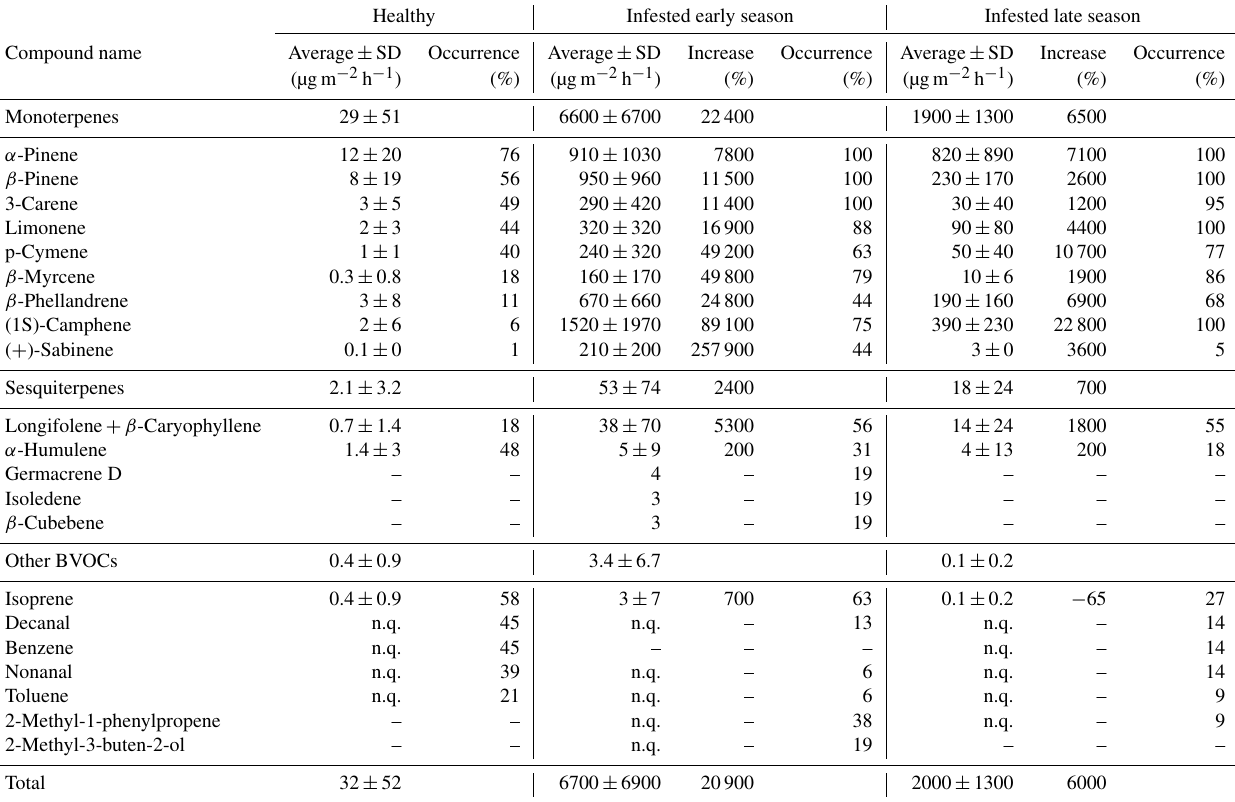
Table 3. Seasonal average temperature standardized emission rates (µgm − 2 h − 1 ± 1 standard deviation) from all Norway spruce trees located in Hyltemossa and Norunda. Presented are the frequently occurring compounds, compound groups (monoterpenes, sesquiterpenes and other BVOCs), and total BVOCs emitted from healthy and infested (early and late season) Norway spruce bark. The increase or decrease (%) is presented for the infested trees as a change in emission rate from healthy to infested. The occurrence (%) indicates how often each compound appeared in the samples throughout the growing season. The compounds that were identified but could not be quantified are presented as n.q. (no quantification). A full list of all identified compounds is found in the Appendix (Table